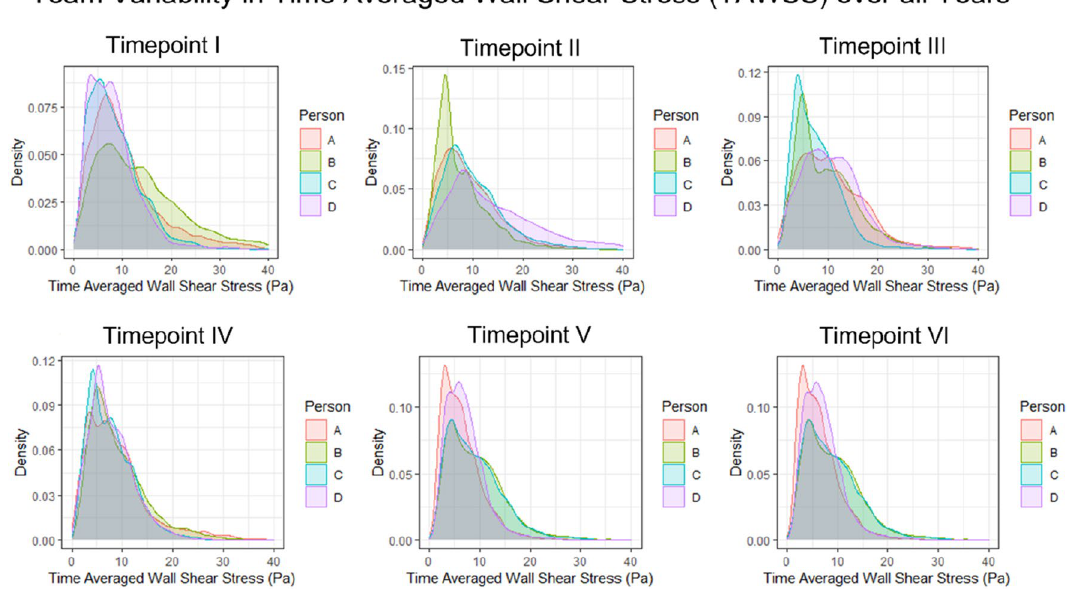
Figure 3. Density distribution plots representing the operator variability in time-averaged wall shear stress distribution at different time